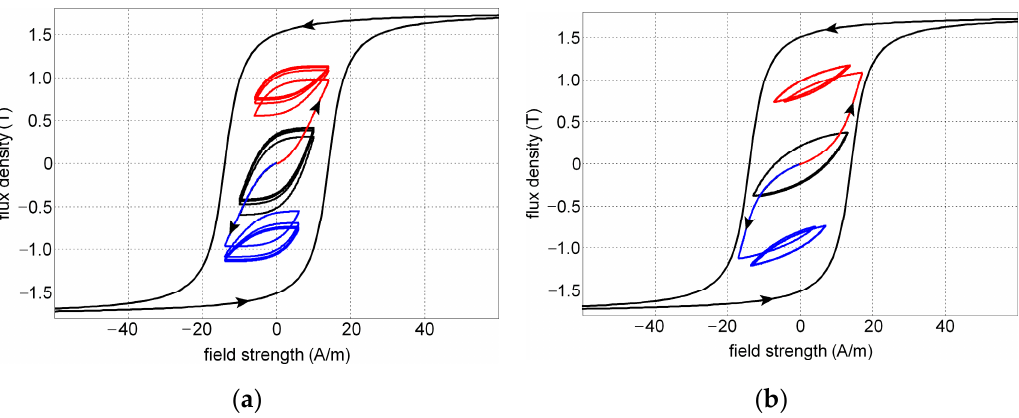
Figure 8. Examples of minor loops determined using the approximation: ( a ) B = f ( H ); ( b ) H = f ( B ).